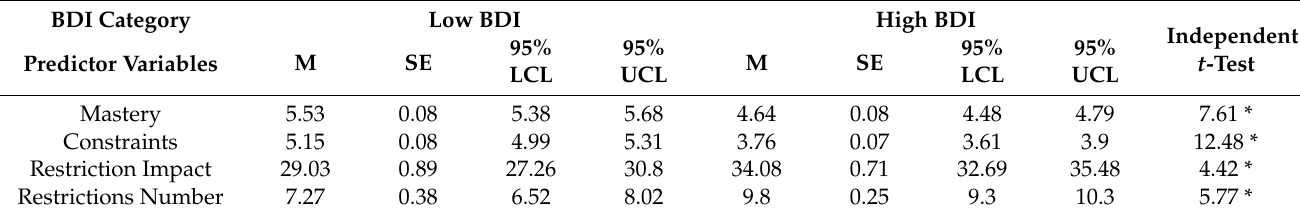
Table 1. Summary of predictor variable means for low and high BDI